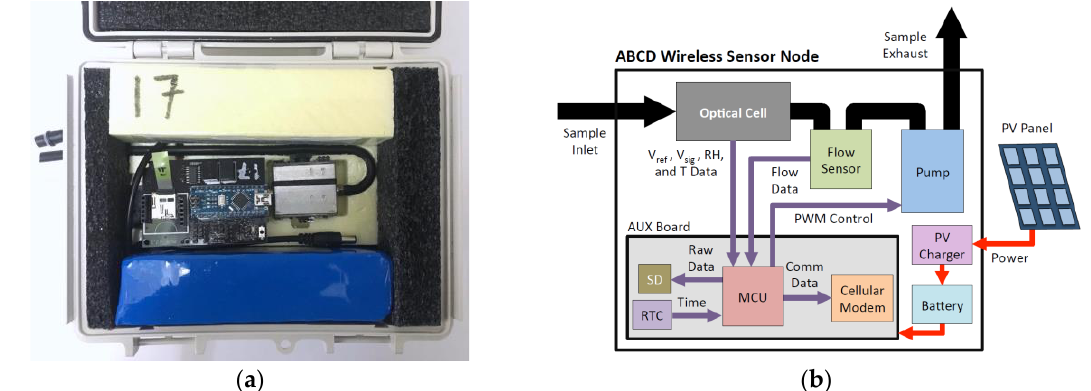
Figure 3. Complete ABCD outdoor deployment package: ( a ) Interior view; ( b ) Functional diagram.